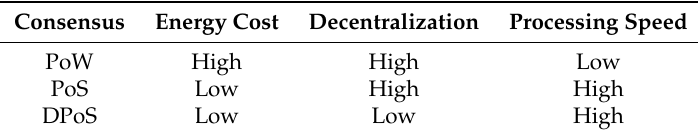
Table 1. Main features of consensus mechanisms.